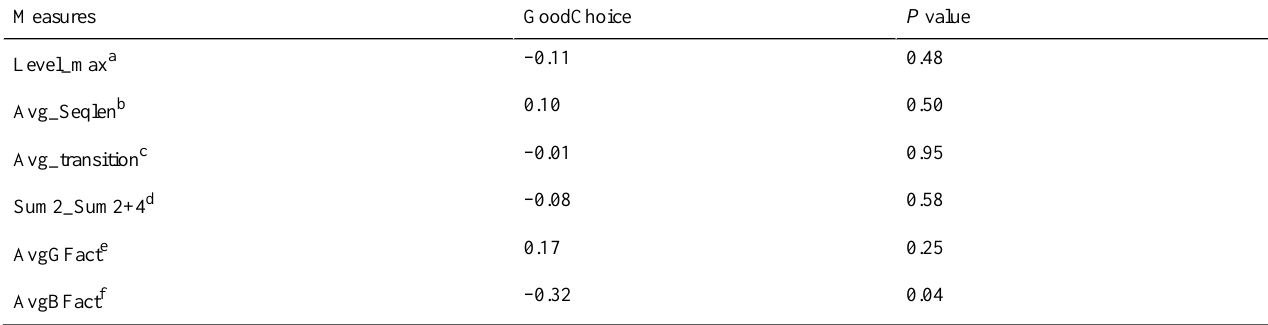
Table 7. Kendall rank correlation coefficients and significance test